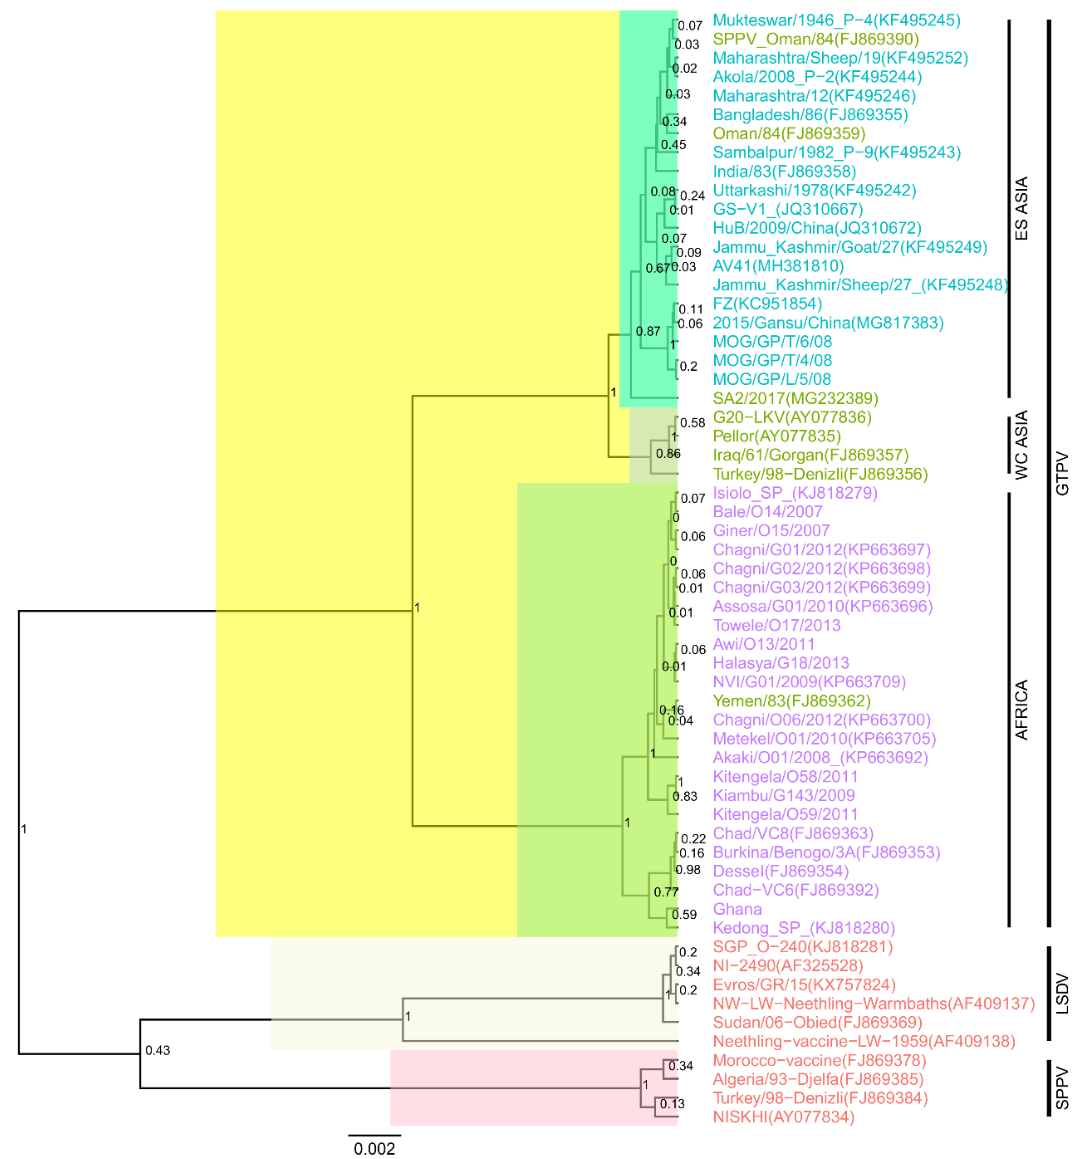
Figure 1. Maximum clade credibility (MCC) tree based on of the complete GPCR complete gene sequences of capripoxviruses. The posterior probabilities are plotted as respective nodes labels. The GTPV sequences are highlighted based their geographical origins (purple for Africa, green for West and Central Asia, blue for East and South Asia). Note GTPV Yemen clustering with African GTPV and GTPV Oman and SPPV Oman, clustering with East and South Asia GTPVs.